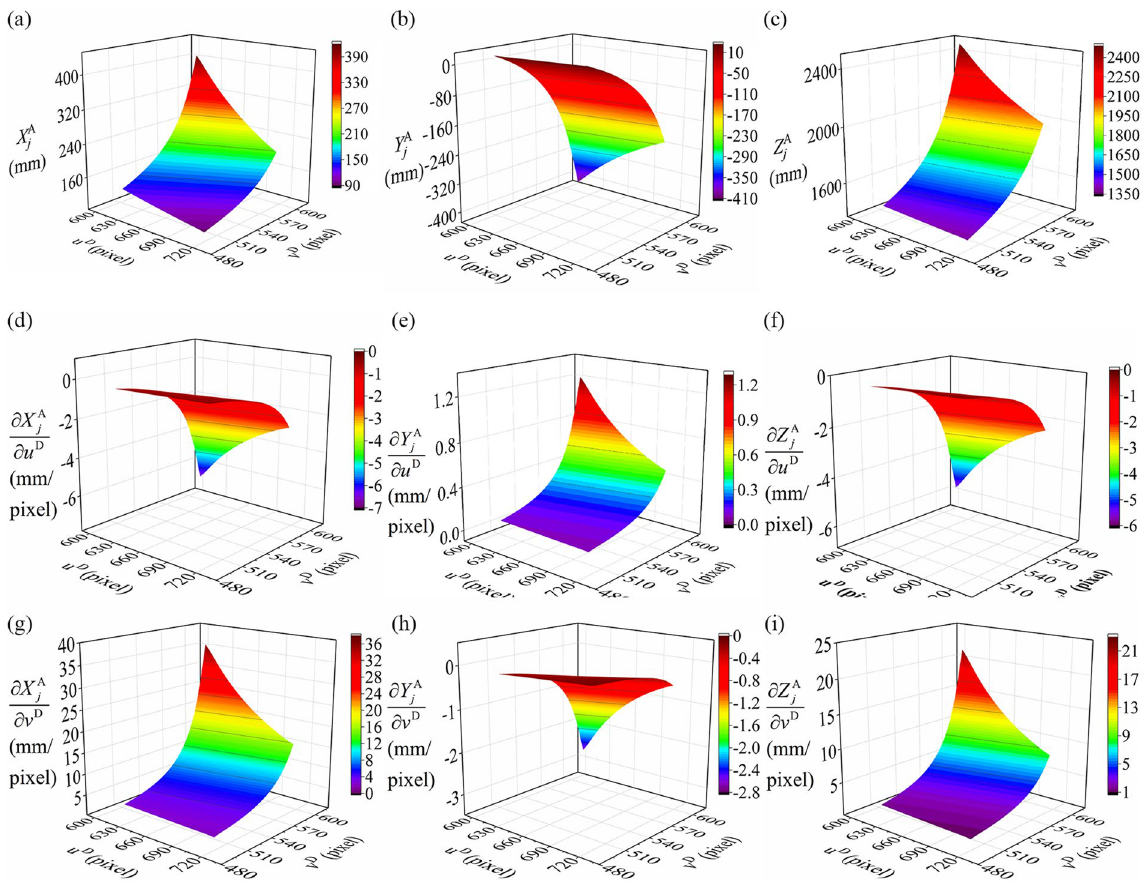
Figure 6. Simulation results of the intrinsic parameters u D , v D . ( a – c ) the relationship between the coordinates X A Y A Z A j , j , j and the intrinsic parameters ∂ Y A /∂ u D , ∂ Z A /∂ u D and the intrinsic parameters u D , v D . ( g – i ) the relationship between the partial derivatives j j ∂ X A